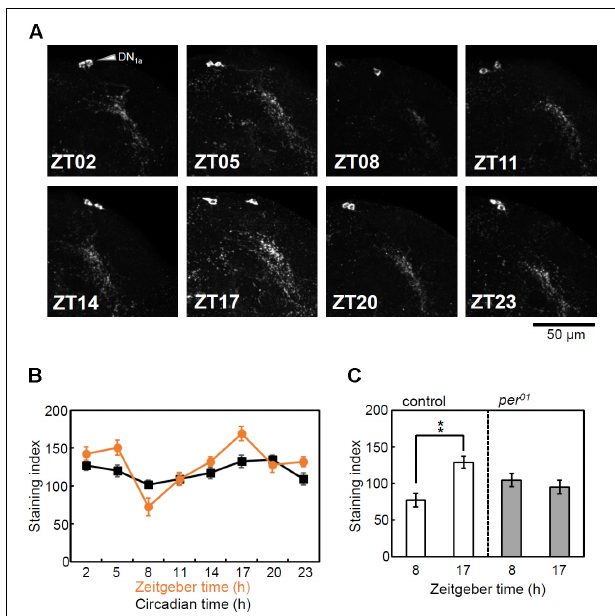
FIGURE 2 | Rhythmic expression of CCHa1. (A) Immunostaining using anti-CCHa1 antibody of the DN 1a neurons at 3 h intervals during LD in w control flies. (B) Mean CCHa1 staining intensity ( ± SEM) of the cell bodies in LD (orange) and DD (black). The LD data represent pooled results from two independent experiments, and DD data represent pool results from three independent experiments. Hemispheres of nine different brains were analyzed for each time point in a single experiment (resulting in n = 18 for the LD experiment and n = 27 for the DD experiment). CircWave analysis (version 1.4, Dr. R. Hut, http://www.euclock.org) revealed that CCHa1 is expressed in a circadian manner in LD ( p < 0.01, n = 18) and DD (DD, p < 0.05, n = 27). Similarly, a one-way analysis of variance (ANOVA) revealed that staining intensity is significantly dependent on time in LD [ F ( 7 ) = 9.565, p < 0.01] and